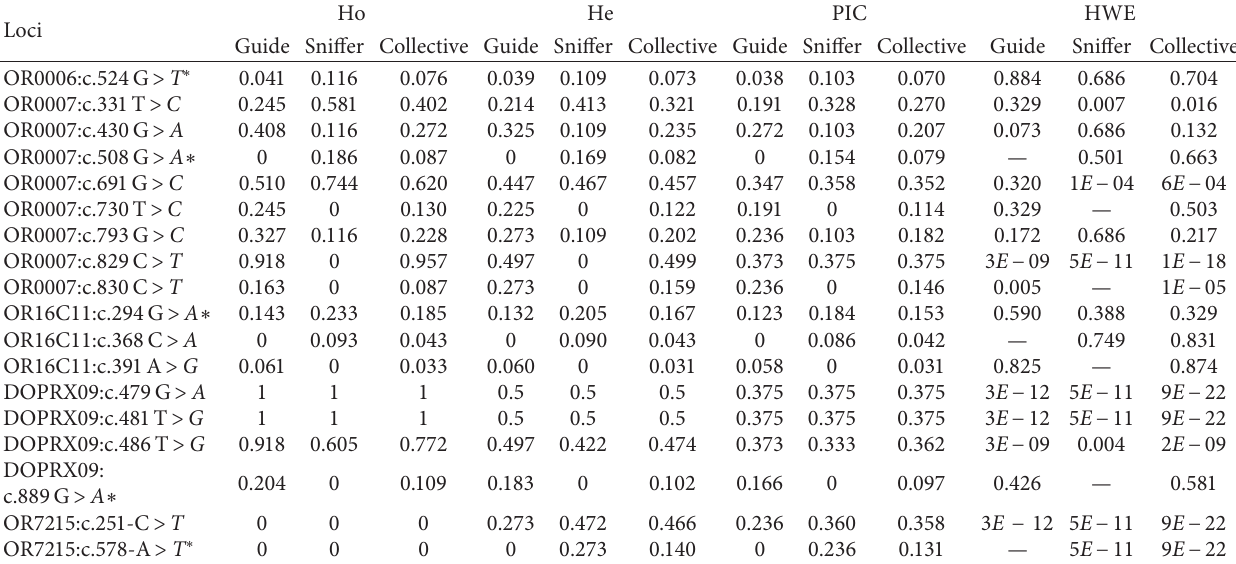
Table 5: Genetic polymorphism and HWE analysis of the collective and working dog subpopulations. Ho He PIC Loci Guide Sniffer Collective Guide Sniffer Collective Guide Sniffer Collective Guide Sniffer Collective